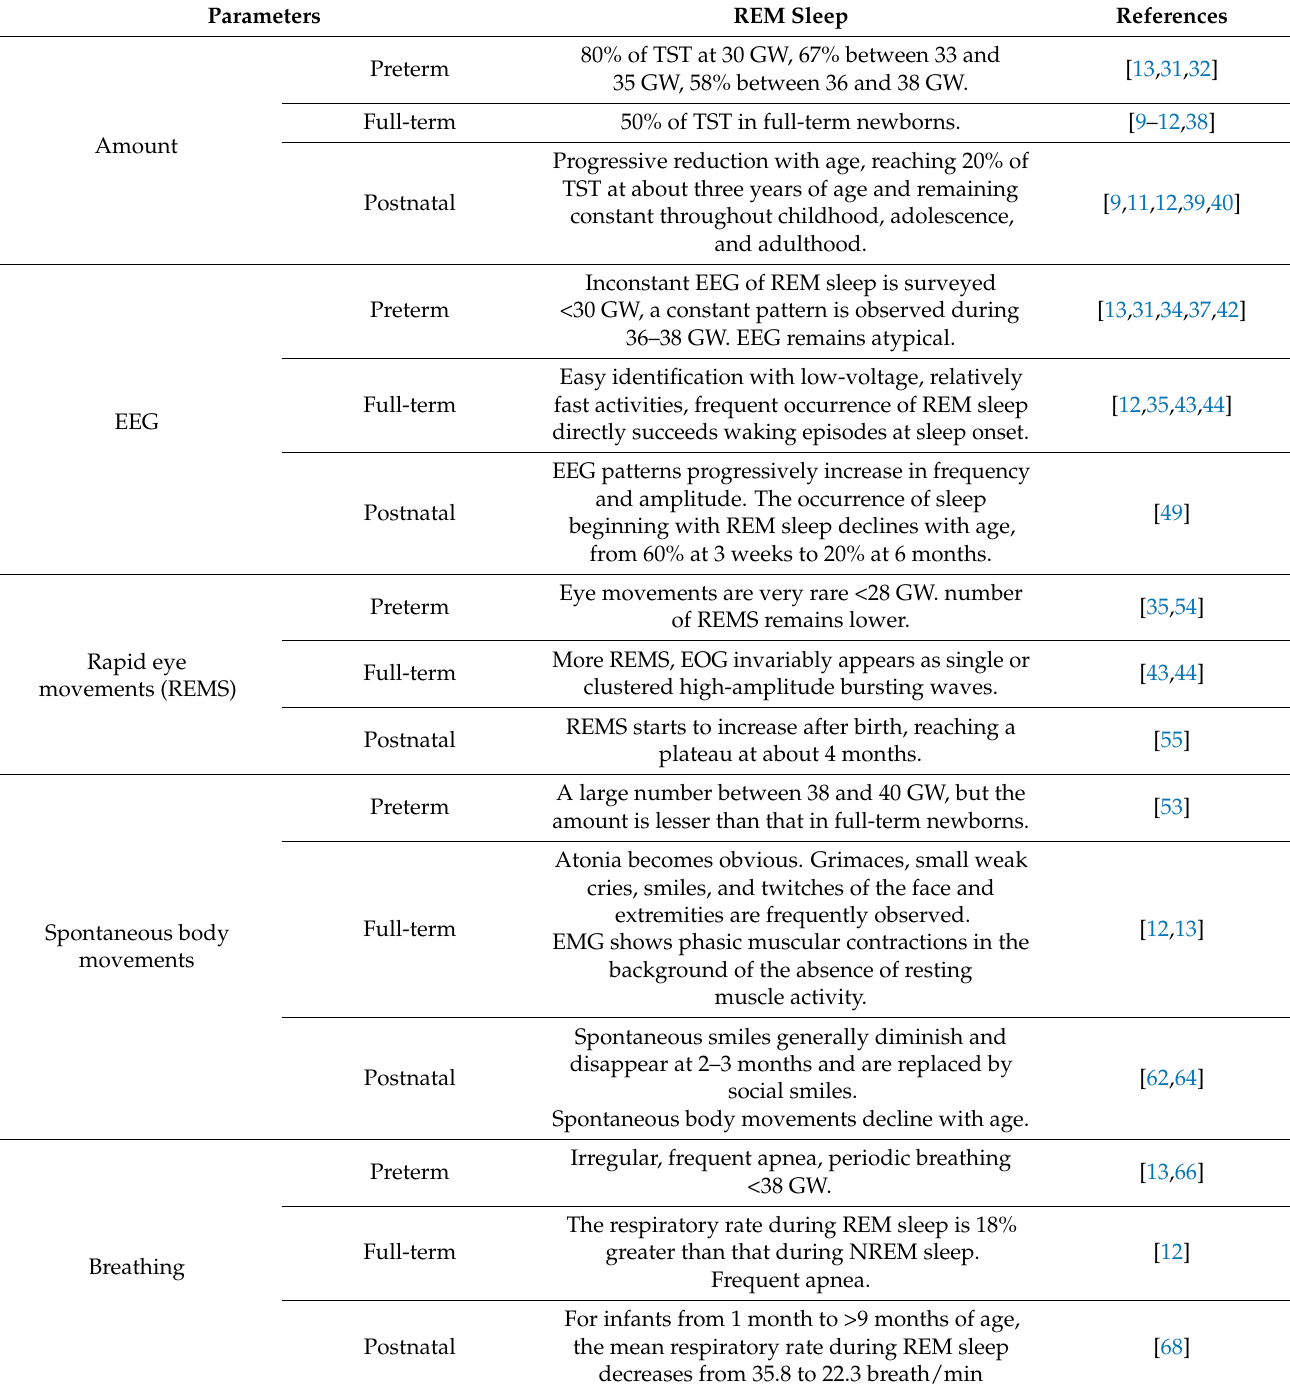
Table 1. Developmental changes of amount, polysomnographic, behavioral, and physiological characteristics, and timing in the sleep-wake cycle of REM sleep across early development of